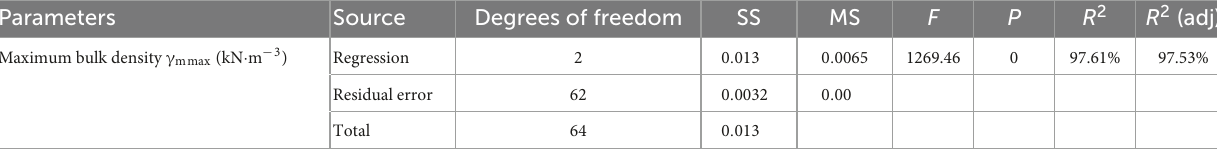
TABLE 4 The variance of the water content and the maximum bulk density. Parameters